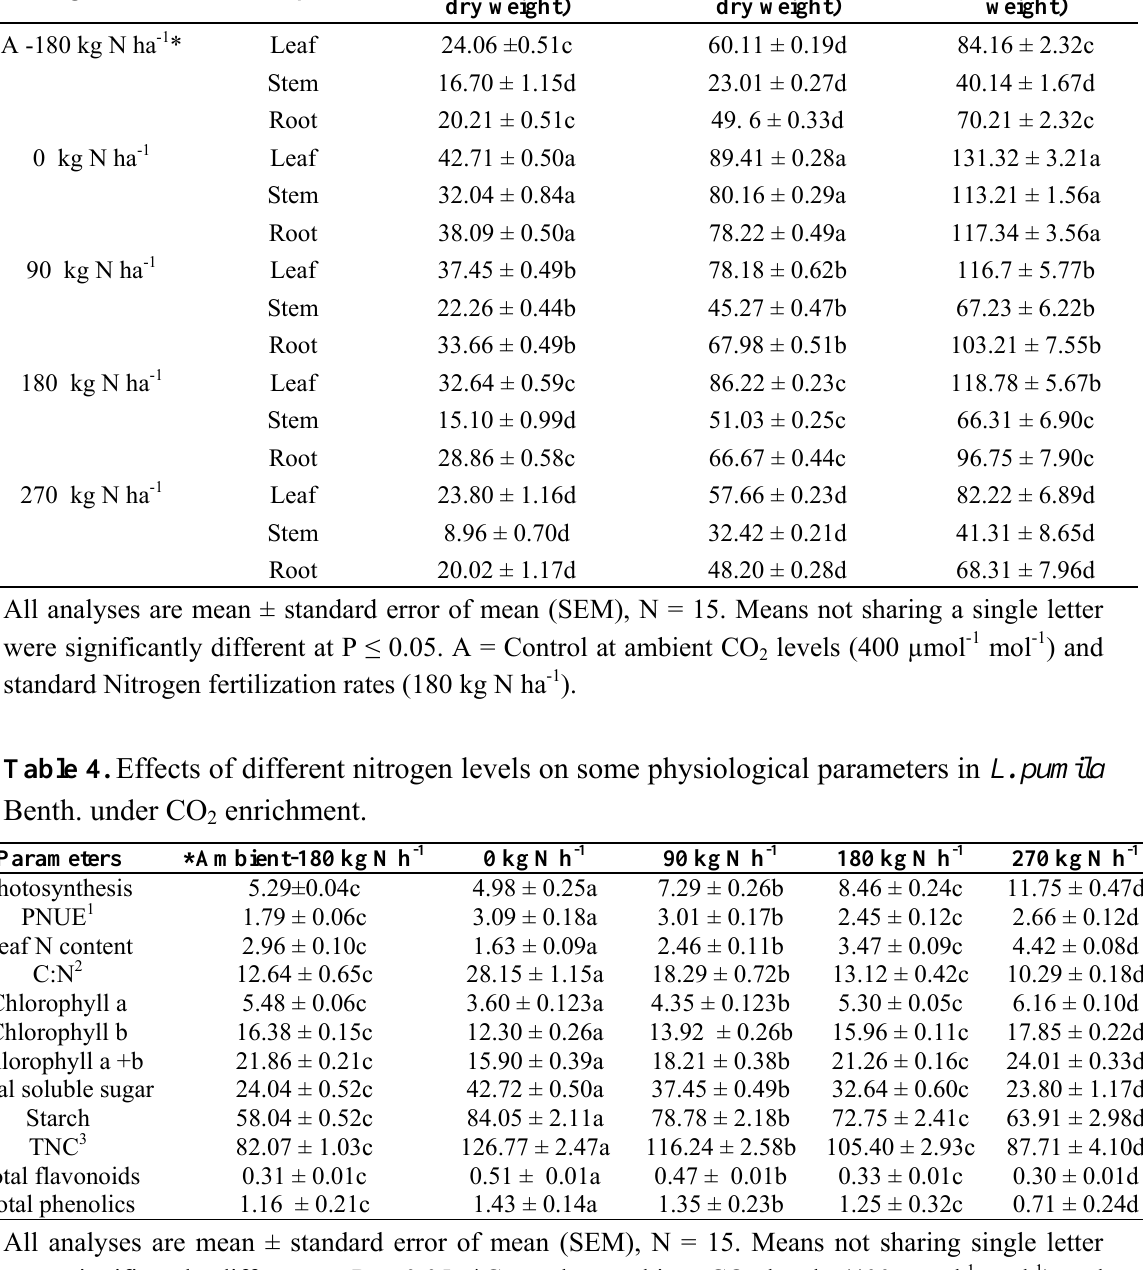
Table 3. Accumulation and partitioning of total soluble sugar (TSS), starch and total non structural carbohydrate (TNC) in different plant parts of Labisia pumila Benth. under different combinations of nitrogen levels and CO